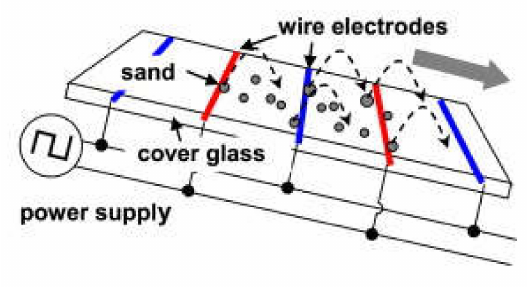
Figure 4. Schematic of electrostatic cleaning